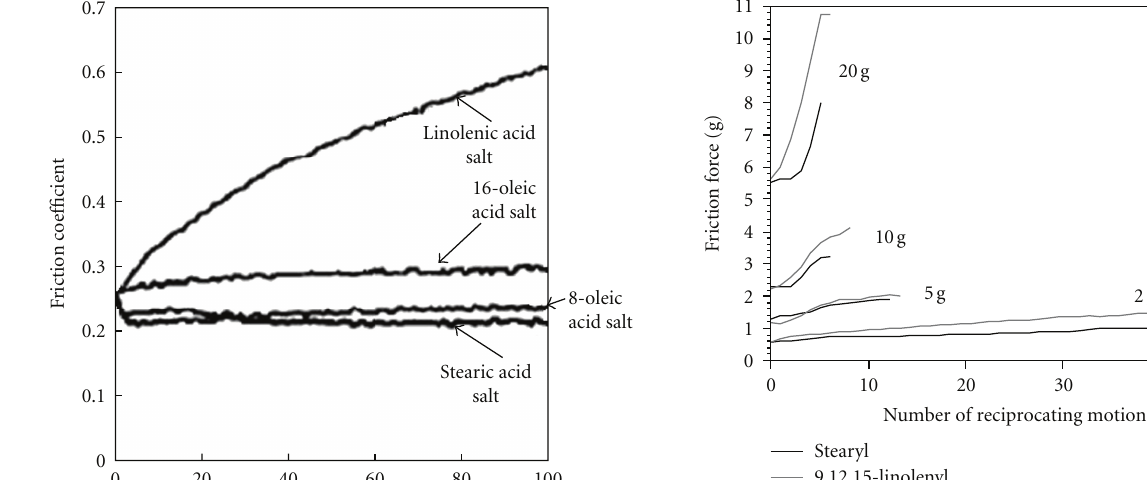
bond at position 8 (the center) has a lower friction value than that at the terminal position 16.